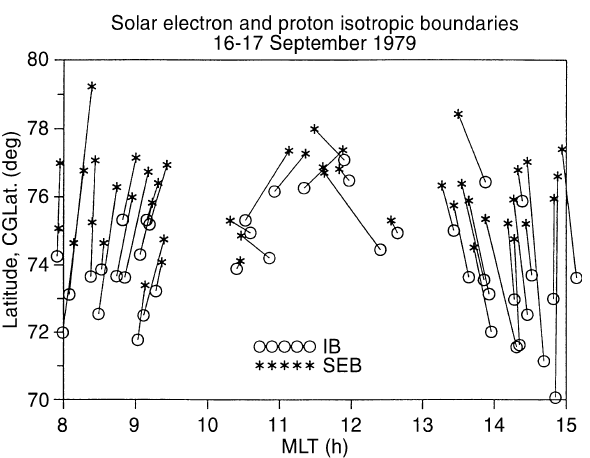
Fig. 10. Statistics of SEB and IB locations during solar electron event on September 16–17, 1979